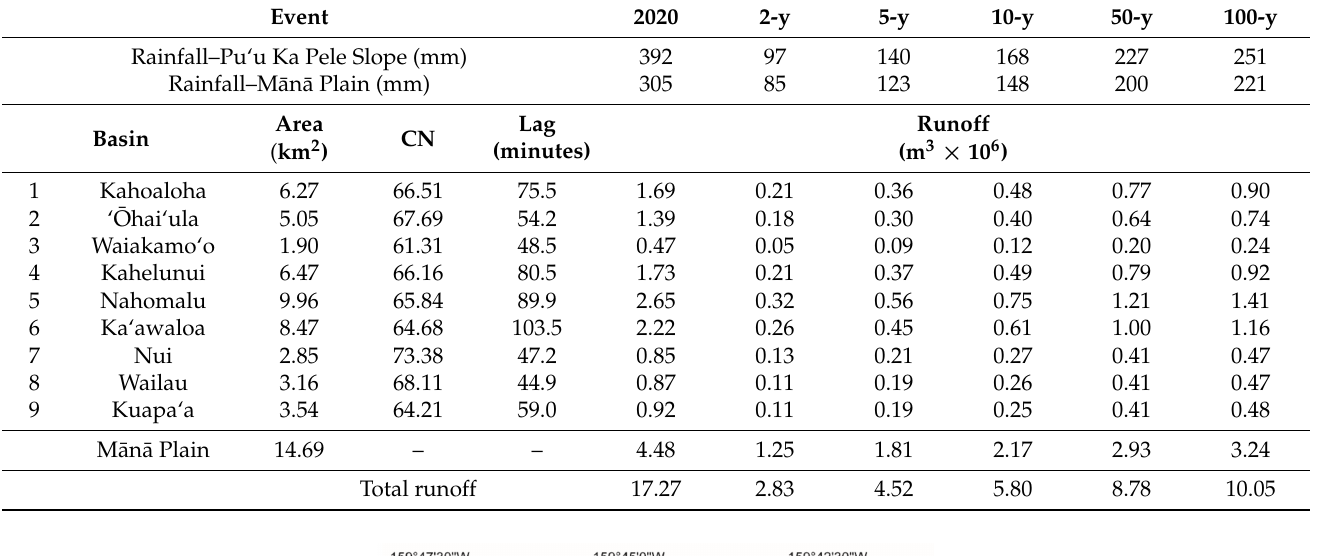
Table 1. March 2020 and hypothetical storm rainfall for different recurrence intervals (years, y), basin characteristics (CN is the SCS curve number), and HEC-HMS runoff estimates for the March 2020 storm and specified 24-h duration frequency storms (see Figure 3 for basin locations).